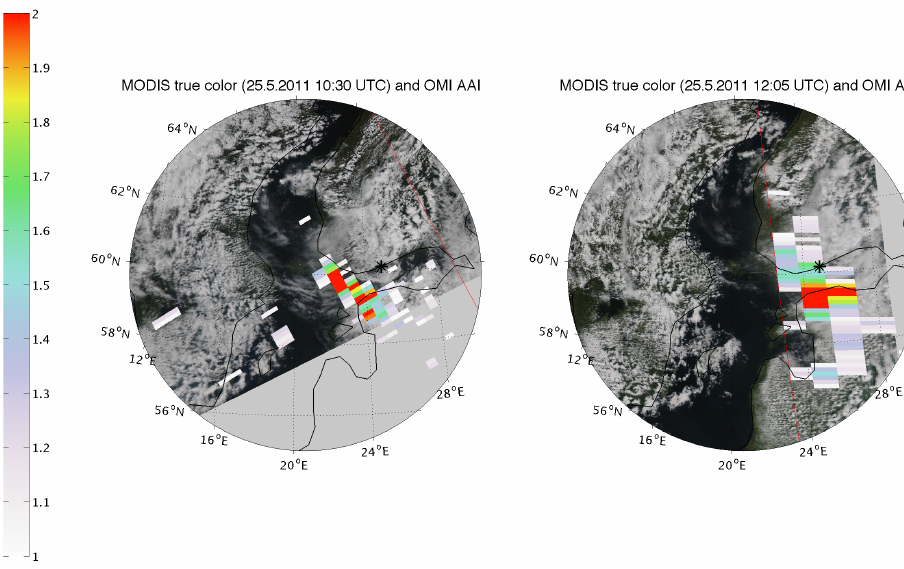
Fig. 3. The OMI AAI values > 1 during the two OMI overpasses that took place on 25 May, together with MODIS/Aqua true color images. The MODIS granules are acquired at 10:30 and 12:05UTC, and the OMI overpassed the same location ∼ 7min